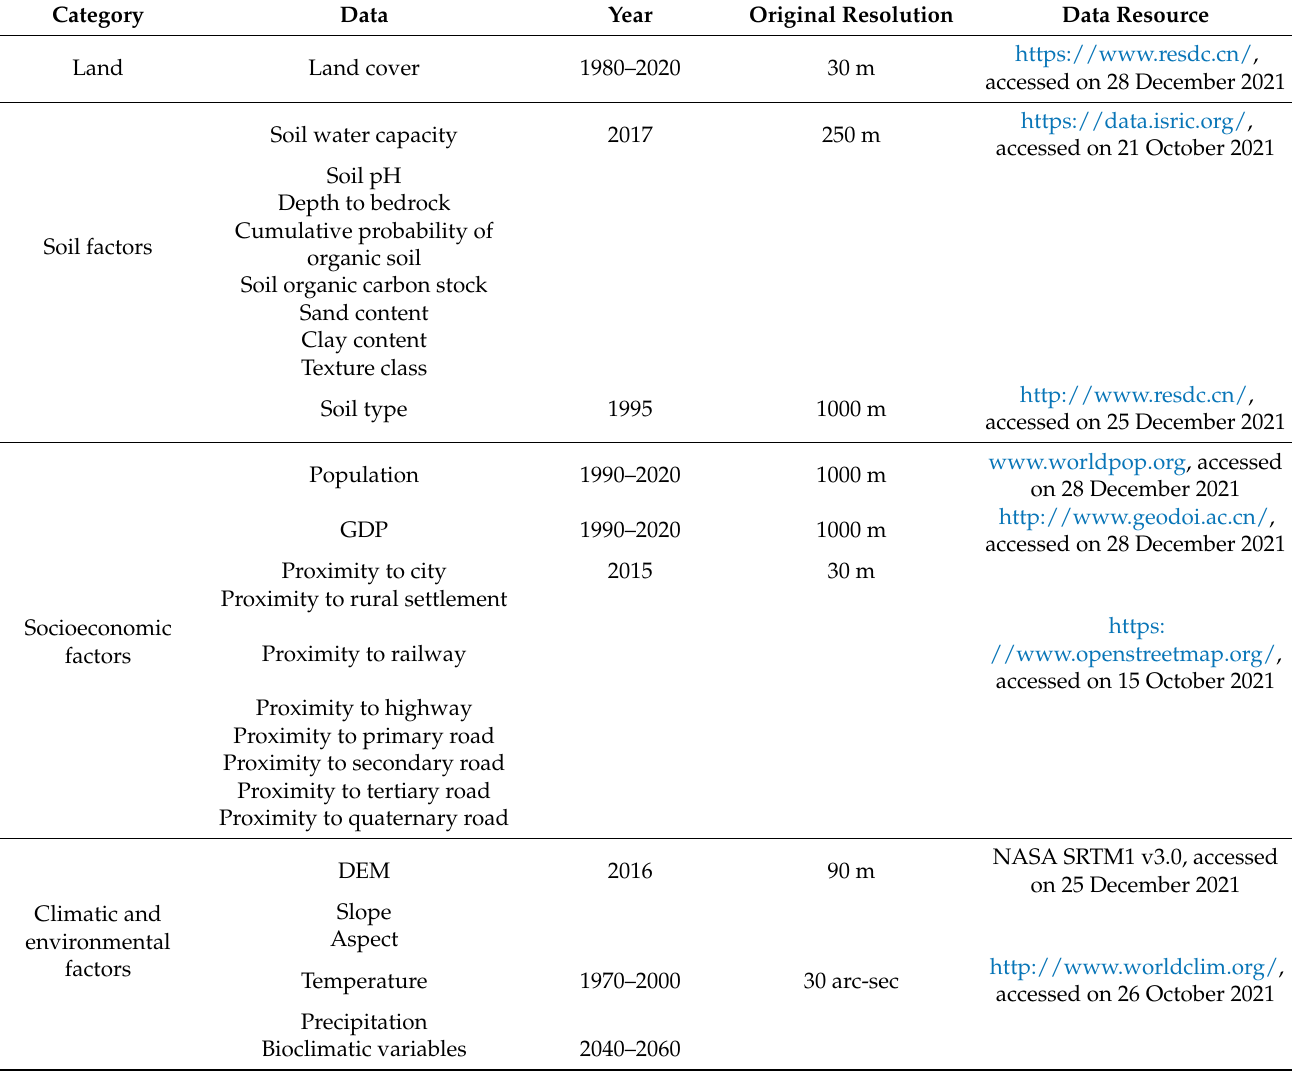
Table 1. The spatial driving factors of the land use change in this